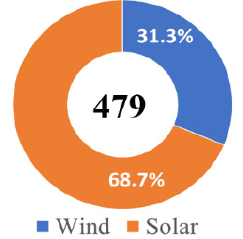
Figure 4. Occurrence of “wind” and “solar” references in most frequent words (TPEM).